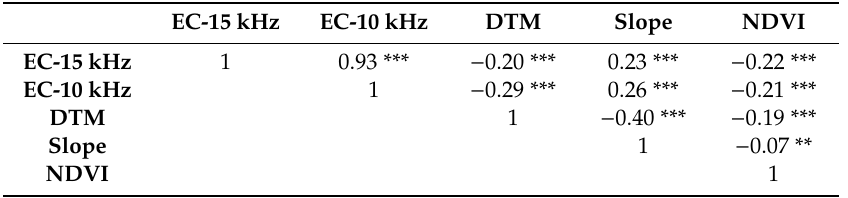
Table 2. Pearson’s correlation coe ffi cients among the variables used to delineate SSMZ, estimated considering the grid nodes with valid EMI measurements (area ‘a’).